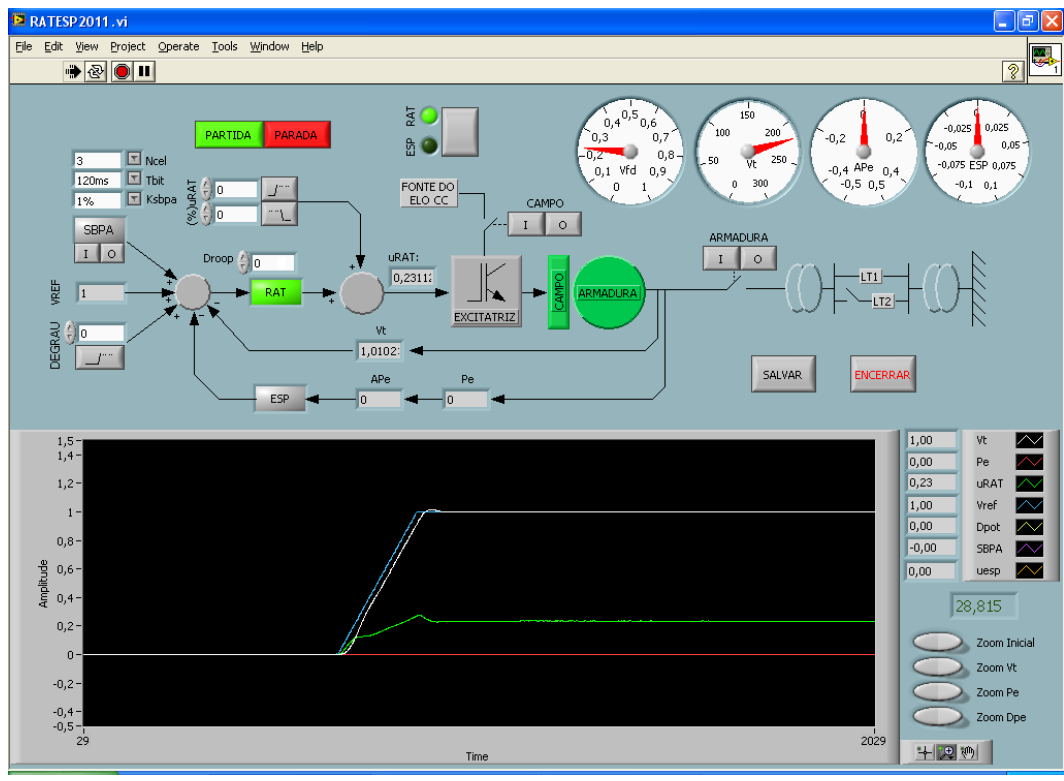
Figure 3. AVR and PSS man – machine interface.